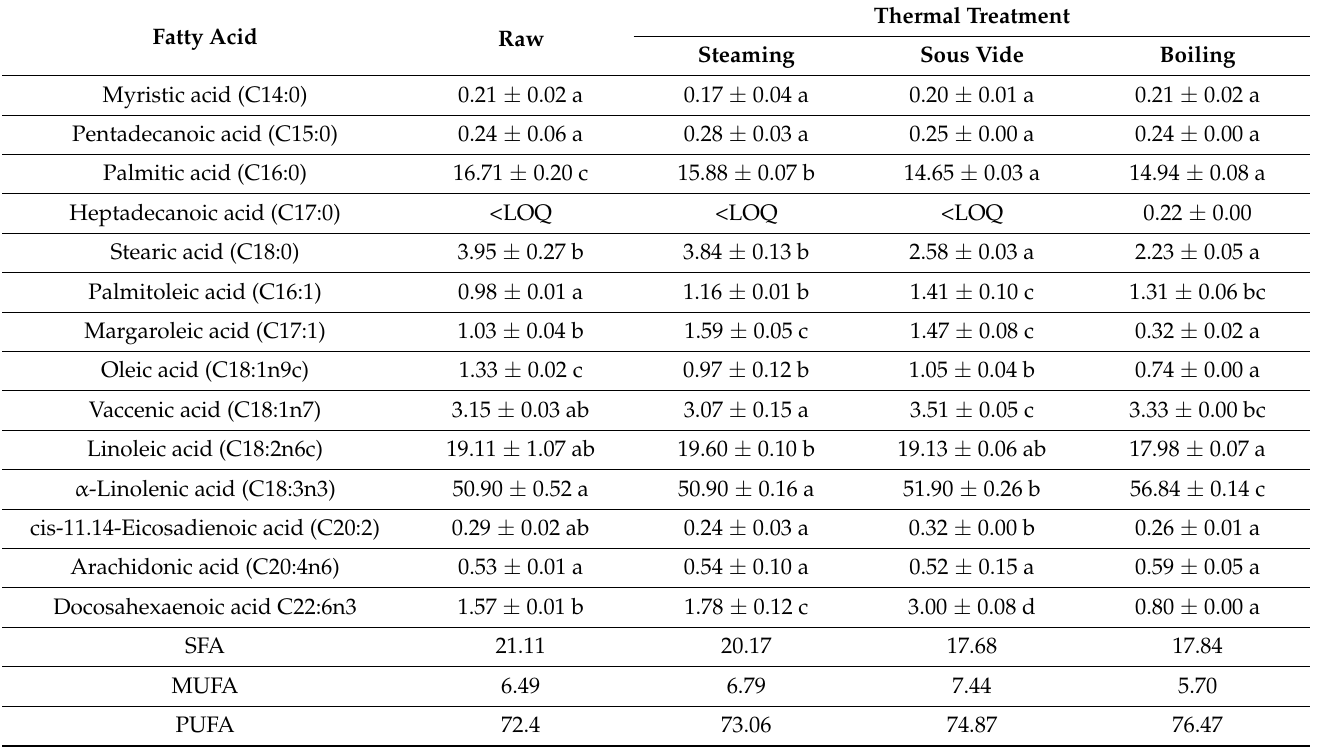
Table 2. Fatty acid profile (values expressed as % of total fatty acids) of raw and thermally processed Brussels